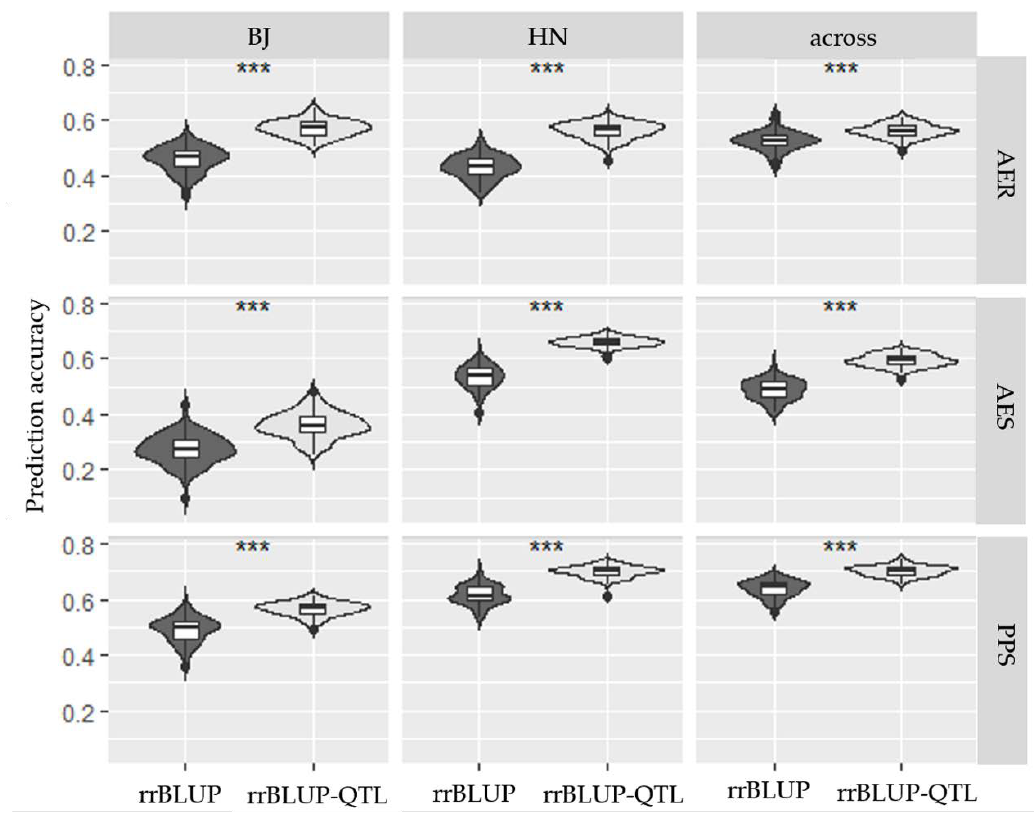
Figure 3. Prediction accuracies for three HMF-related traits generated by rrBLUP and rrBLUP-QTL for Beijing (BJ) and Hainan (HN) and across both locations (across). *** p < 0.001, means prediction accuracies as determined by rrBLUP and rrBLUP-QTL were significantly different.